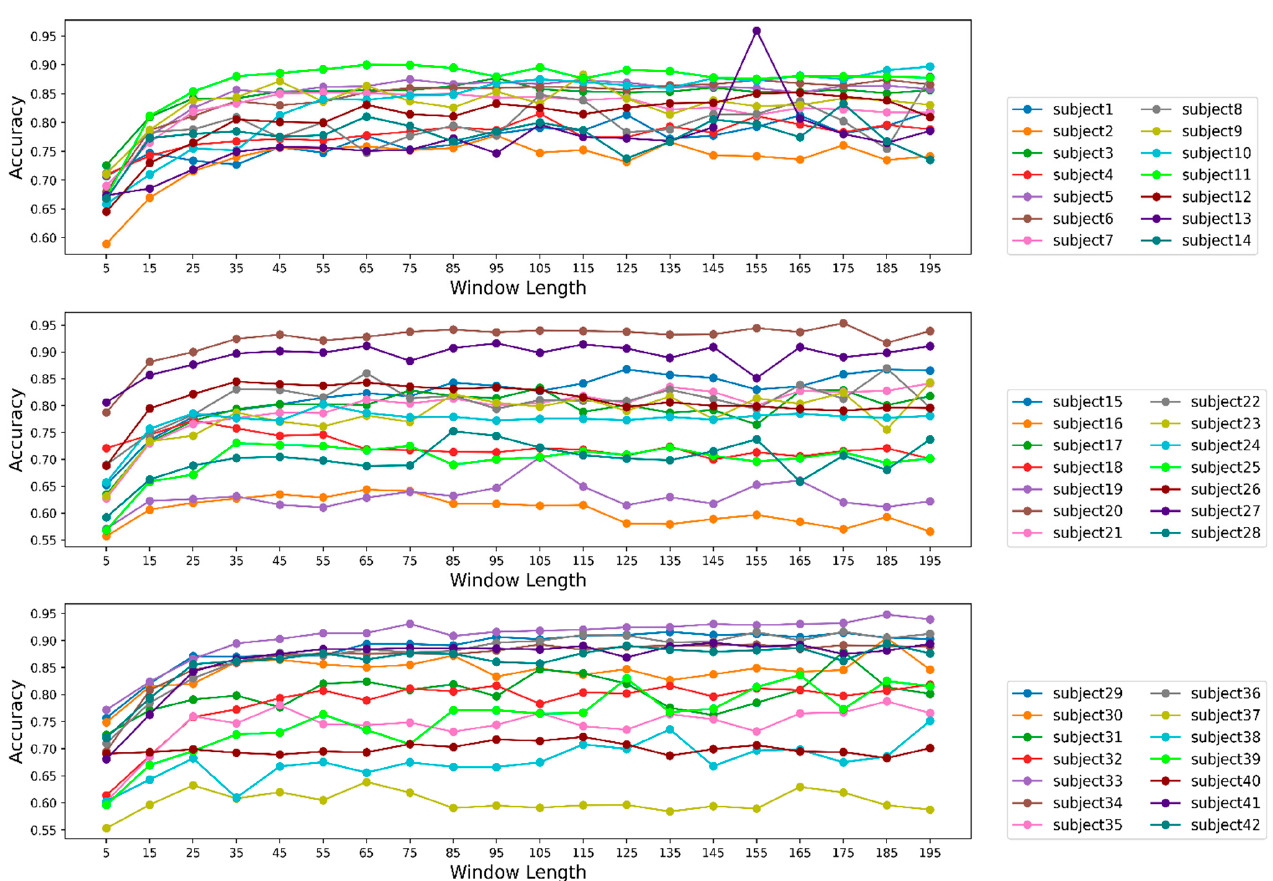
Figure 9. Accuracies for each participant for different window lengths.